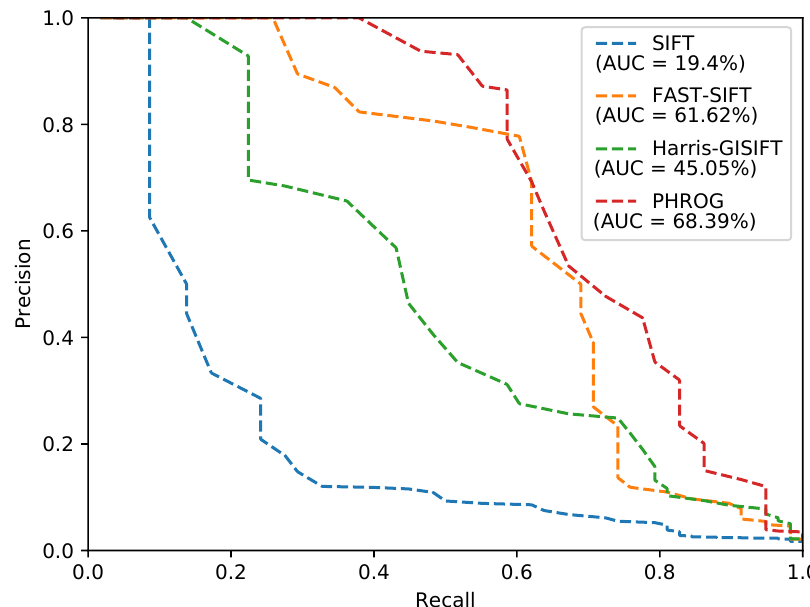
Figure 14. Precision-Recall curves from the “urban” dataset and AUC ( Area Under the Curve ) for each method.